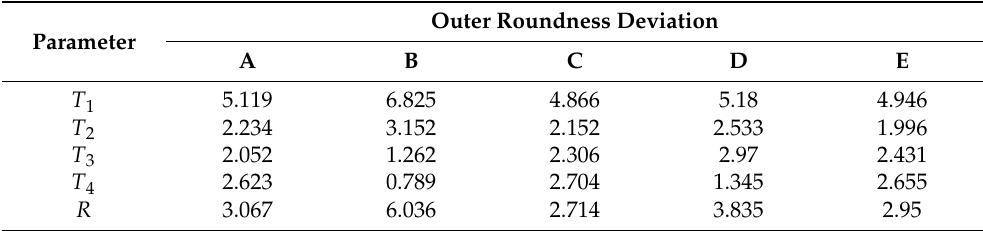
Table 6. Range analysis of outer roundness